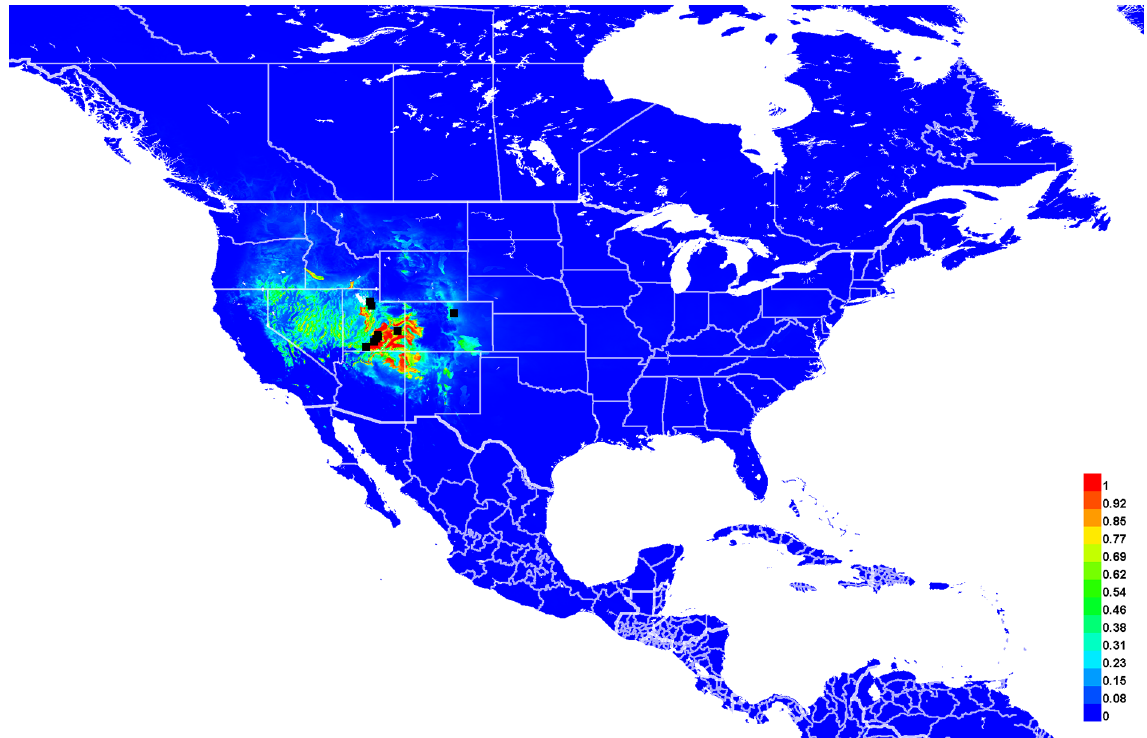
Fig. 41. Georeferenced collection records of Lasioglossum ( D. ) griswoldi Gibbs, 2009 (black squares) and predicted distribution by maximum entropy ecological niche modeling in Maxent (colour shading). Warmer colours indicate higher cloglog probability of